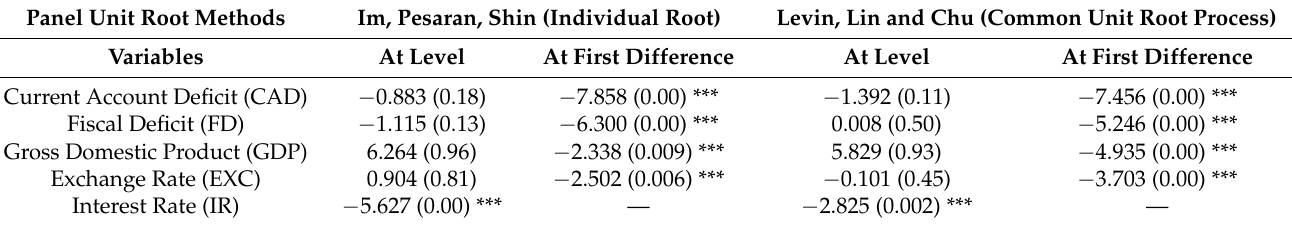
Table 4. Results of panel unit root